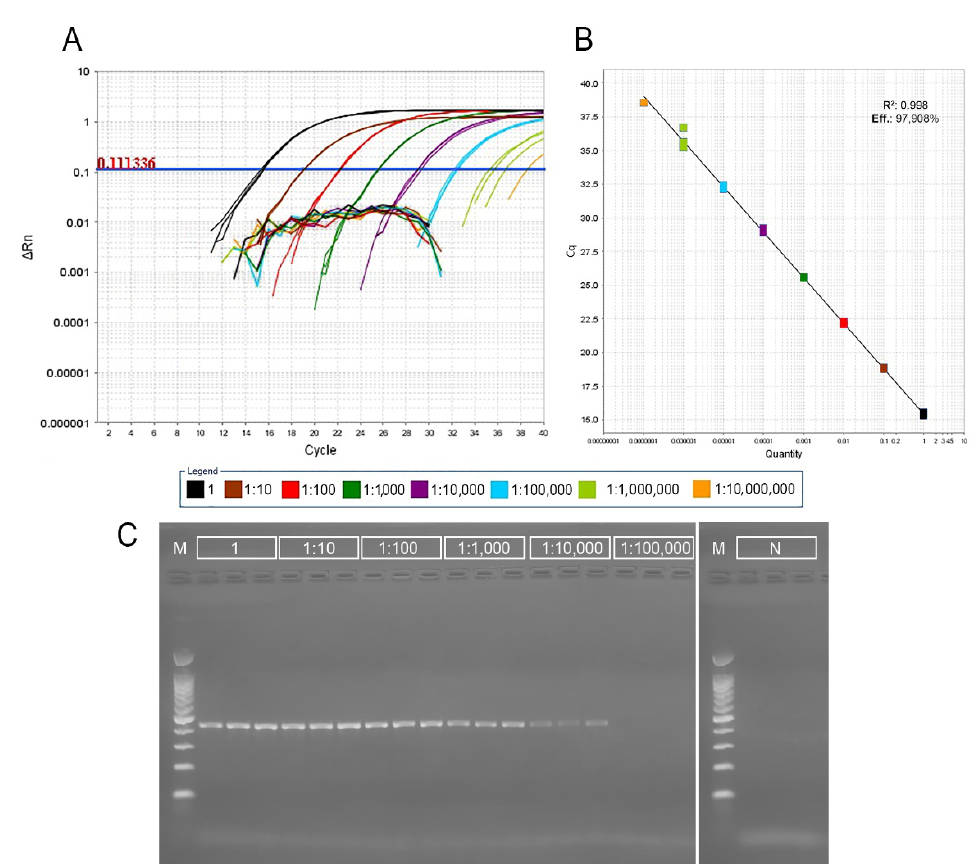
Figure 1. Sensitivity comparison between real-time PCR and conventional PCR assays for the detection of GBV-1 on grapevine accession PMC-313 using three replicates of a 10-fold dilution series. Isolation of DNA was performed using the DNeasy Plant Mini Kit (Qiagen, Hilden, Germany). 1—undiluted extract; 1:10–1:10,000,000—serial 10-fold dilutions. ( A ) Plots of DNA dilution series against threshold cycles values showing the dynamic range of the real-time PCR assay detection. The broken lines below the threshold represents negative controls for each dilution. ( B ) Standard curve analysis of the real-time PCR sensitivity: x-axis—DNA dilution; y -axis—measured quantification cycle (Cq) value; R2—determination coefficient; Eff.- real-time PCR efficiency. ( C ) PCR products obtained by conventional PCR on a 1.5% TBE agarose gel; M-marker (GelPilot 100 bp Plus Ladder, Qiagen, Hilden, Germany), N—negative controls for undiluted extract.